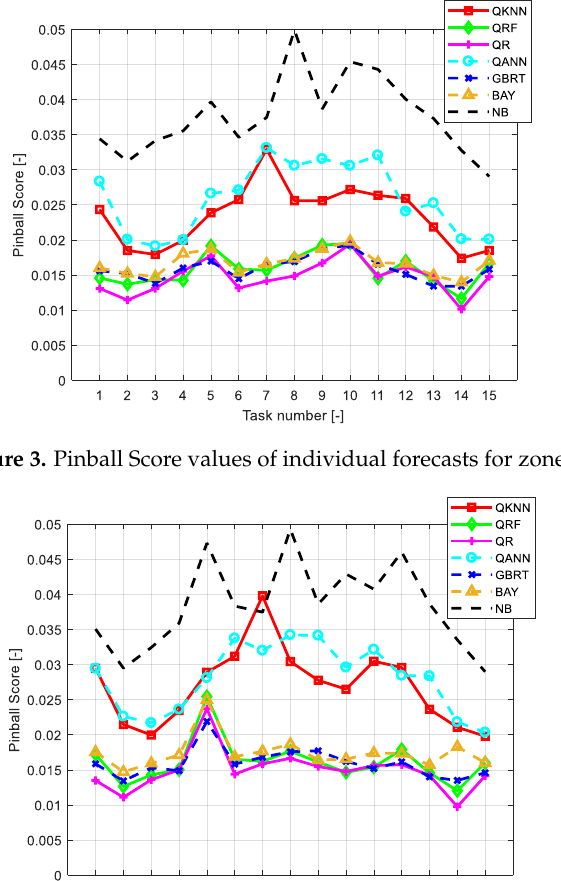
Figure 2. Pinball Score values of individual forecasts for zone 1.